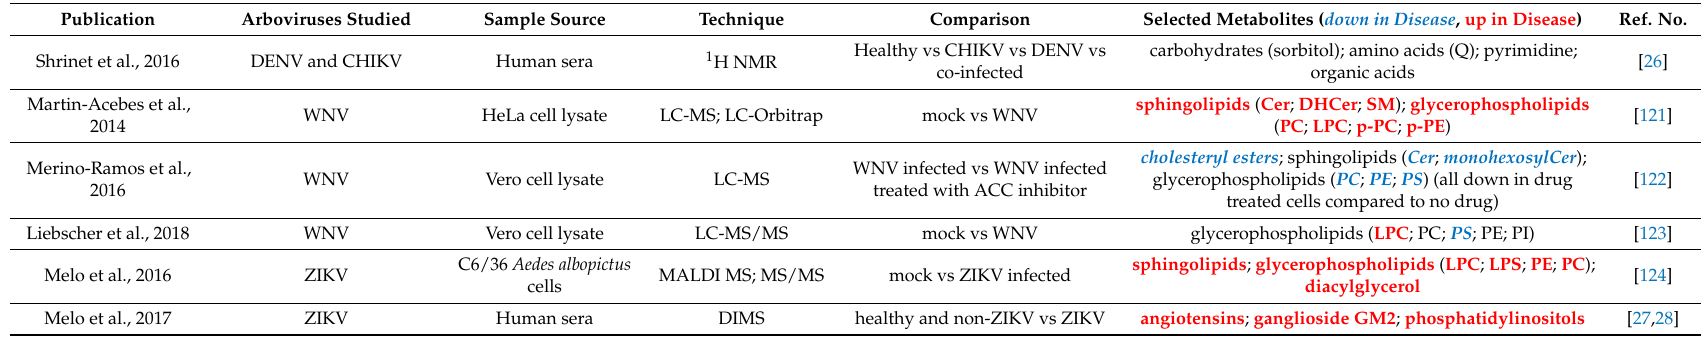
Table 4. Selected metabolites from papers on chikungunya virus (CHIKV), West Nile virus (WNV), and Zika virus (ZIKV). Metabolites generally increased in disease are in red, decreased metabolites are in blue. Black metabolites have mixed results in the corresponding publication. If not specified, LC was reversed-phase. Standard single letter amino acid abbreviations are